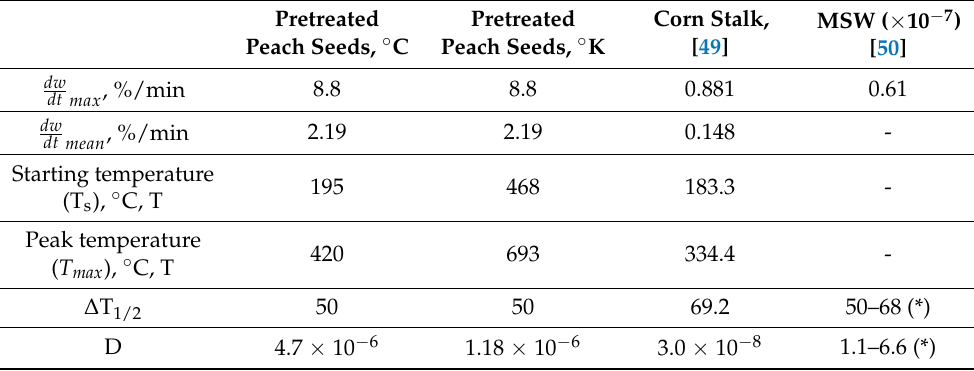
Table 10. Pyrolysis characteristics parameters indexes of pretreated peach seeds, and different types of biomass and volatile release index,